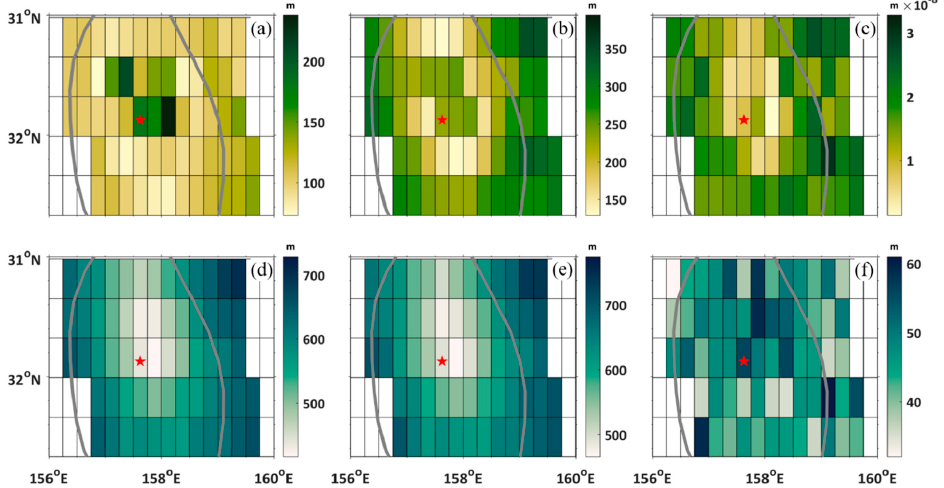
Figure 9. STMW and North Pacific Intermediate Water (NPIW). ( a ) Upper and ( b ) lower boundaries of the STMW. ( c ) Intensity of the STMW. ( d ) Upper and ( e ) lower boundaries of the NPIW. ( f ) The thickness of the NPIW.